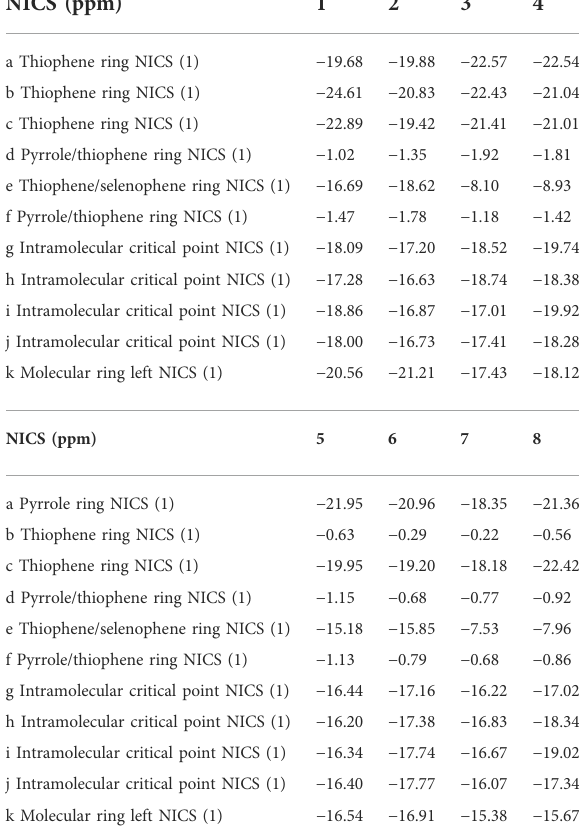
TABLE 3 NICS (1) values for 1 – 8.